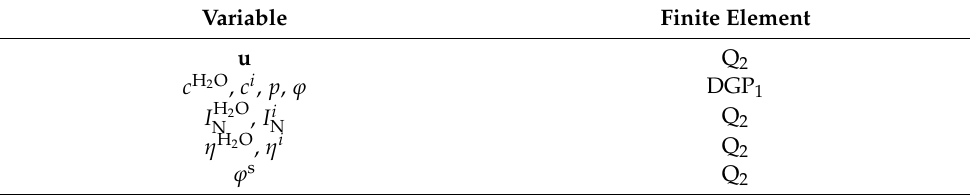
Table 4. Finite elements used for example 2.